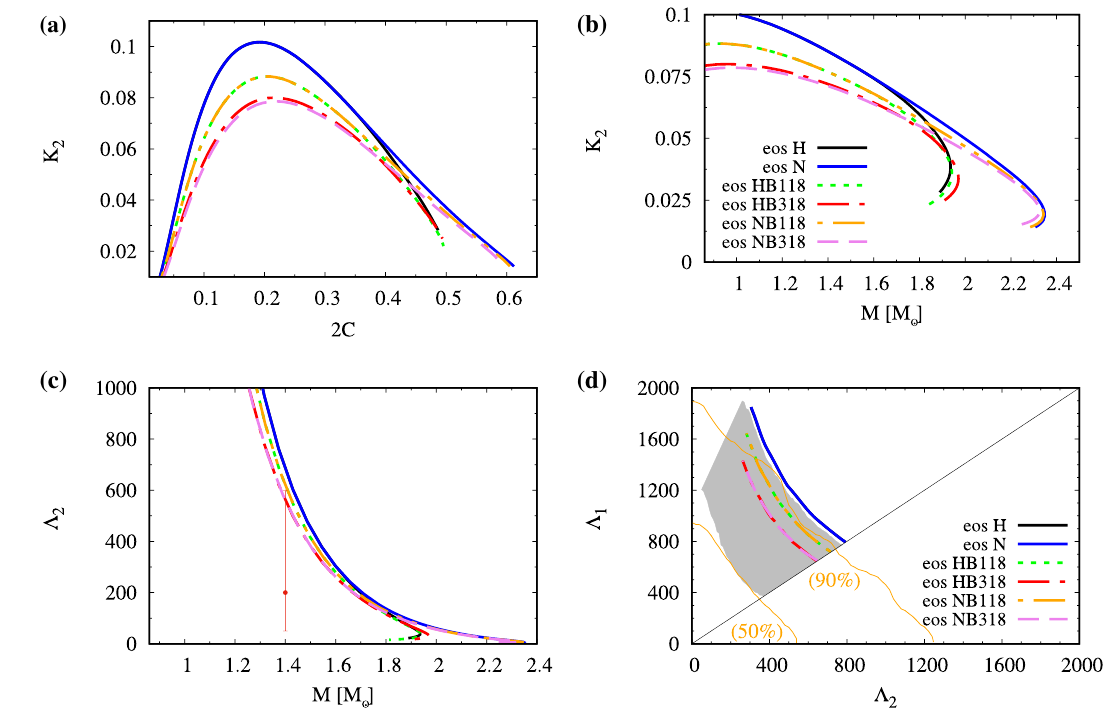
Fig. 3 Top figures: Love number as a function of a the compactness and b of the stellar mass. Bottom figures: Dimensionless tidal polarizability c as a function of the stellar mass and d (Λ 1 ,Λ 2 ) window obtained from the LIGO and Virgo